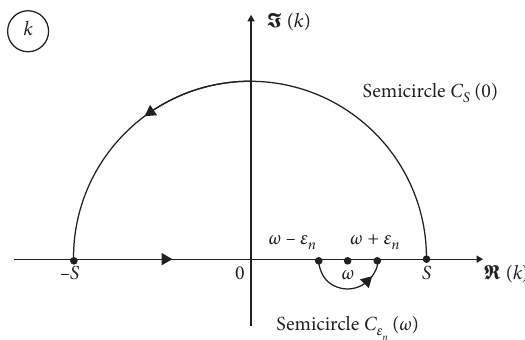
Figure 4: Closed contour in the upper half-plane for evaluation of I